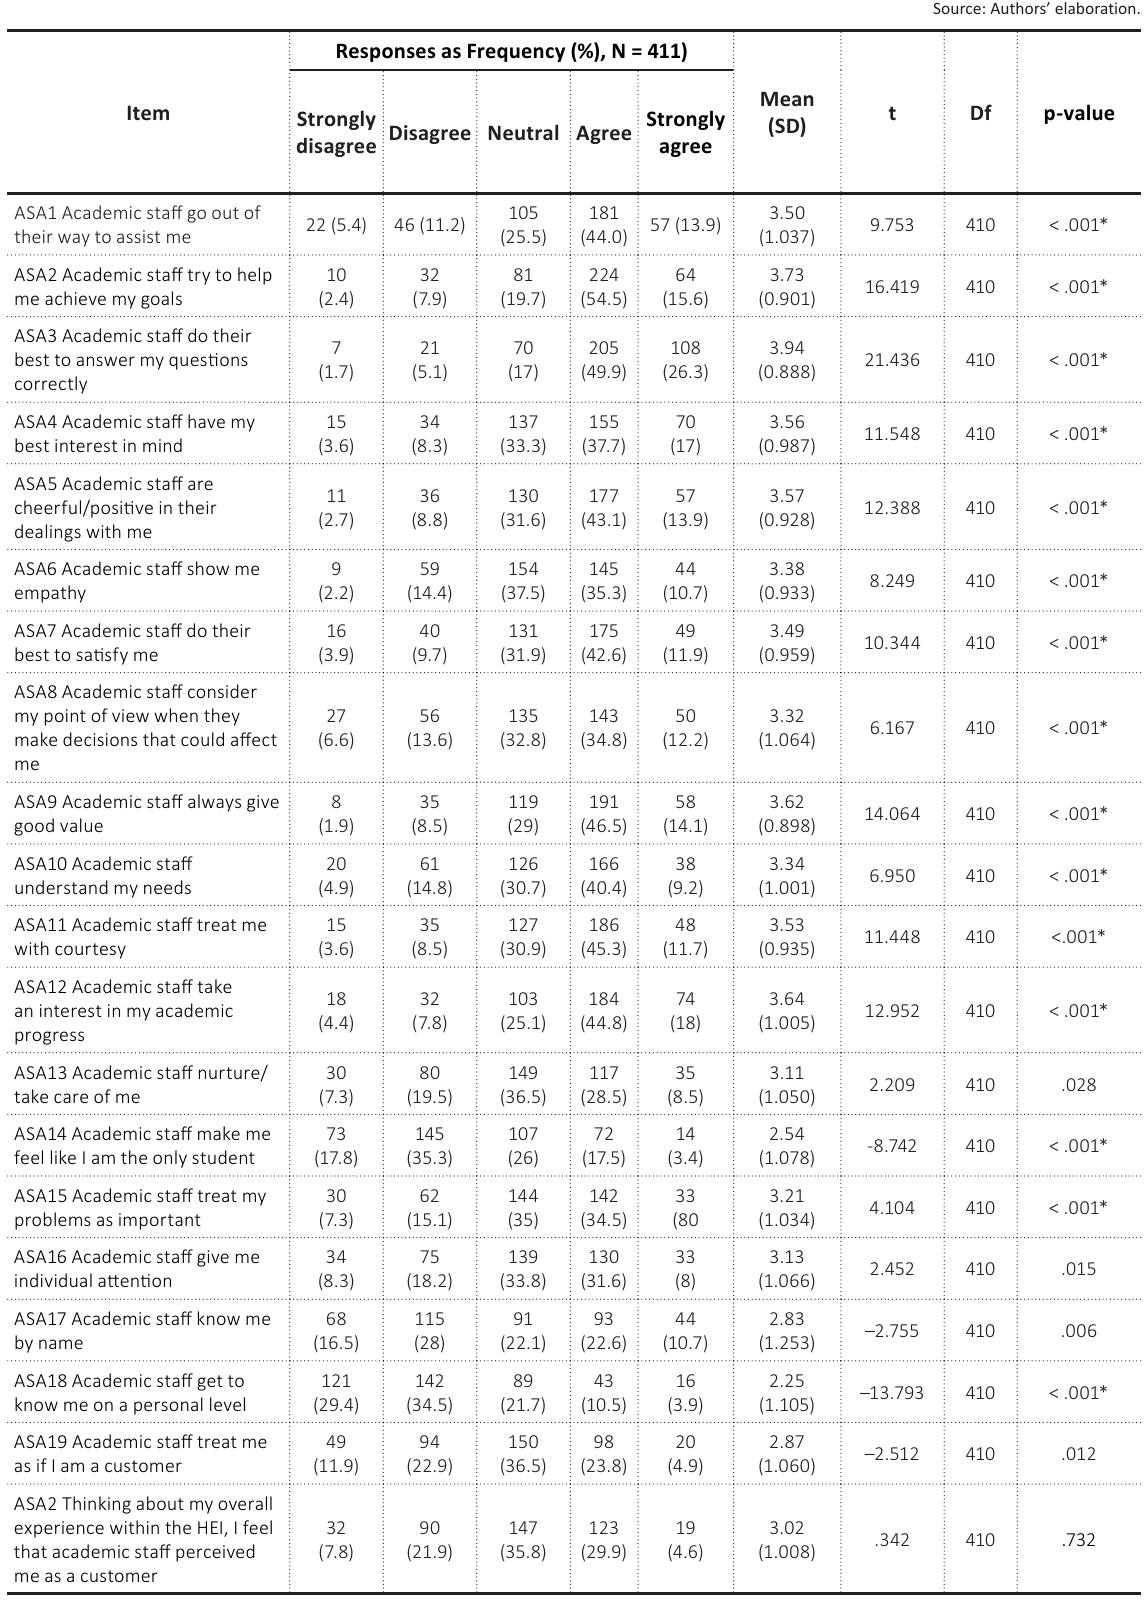
Source: Authors’ elaboration.